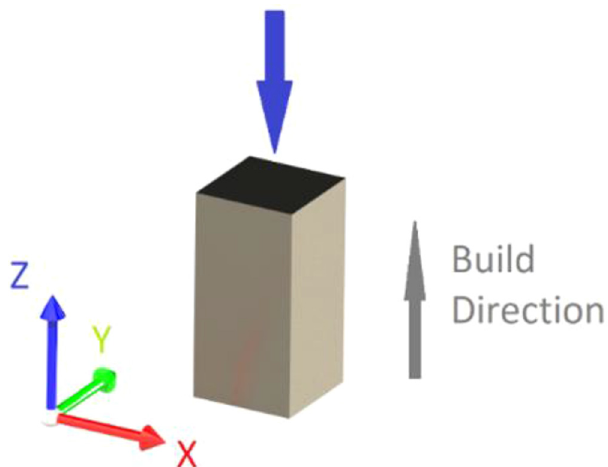
Fig. 1. Positioning of the specimens in the